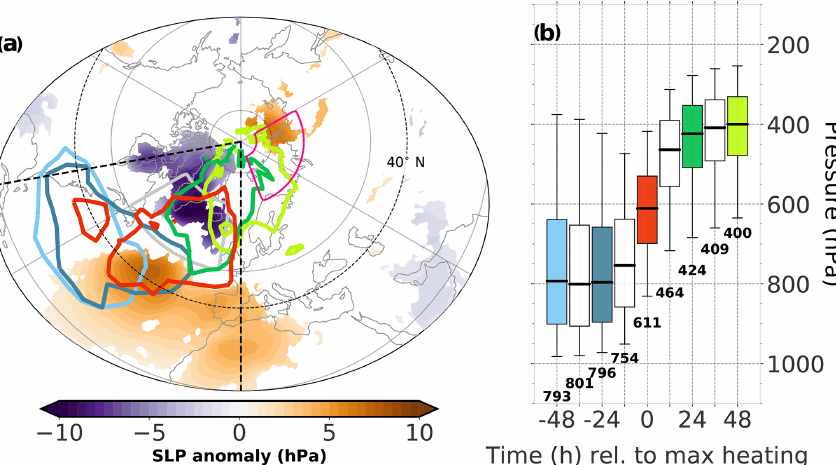
Figure 11. Spatial and vertical evolution of Ural blocking trajectories belonging to the main heating domain (region denoted by the black dashed lines in panel a ). (a) Significant SLP anomalies 2d prior to the timing of the event defined peak frequency in max heating within the main heating domain (hPa, shading, significant when ≥ 67% of the 30 members obtain the same sign in the anomaly as the composite mean), overlaid with density contours of trajectories at the location of max heating (red), 1d before (turquoise), 2d before (light blue), 1d after (green) and 2d after (light green), normalized by the total number of trajectories included at the corresponding time step and area weighted by each grid cell area (5 ◦ × 5 ◦ ). Each density contour shows the 4%(10 6 km 2 ) − 1 value. The magenta box denotes the Ural sector, i.e., the origin region for the blocking trajectories, and the gray box denotes the region used for analyzing cyclone activities. The dashed black circle shows the latitude band at 40 ◦ N. (b) Evolution of pressure along trajectories relative to the time of maximum heating within the main A domain; coloring as in panel (a) . Median values per 12-hourly time slots are shown in text and as horizontal lines, boxes denote the interquartile range, and whiskers show the 5th–95th percentile